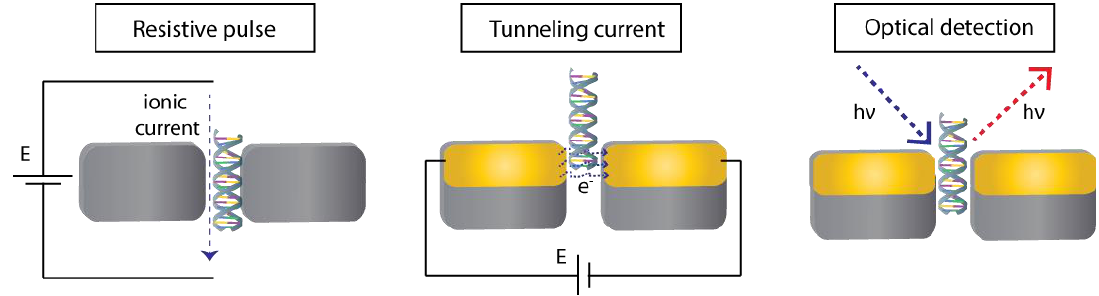
Figure 4. Schematics of different methods to detect the translocation events through a nanopore: resistive pulse, tunneling current and optical detection.